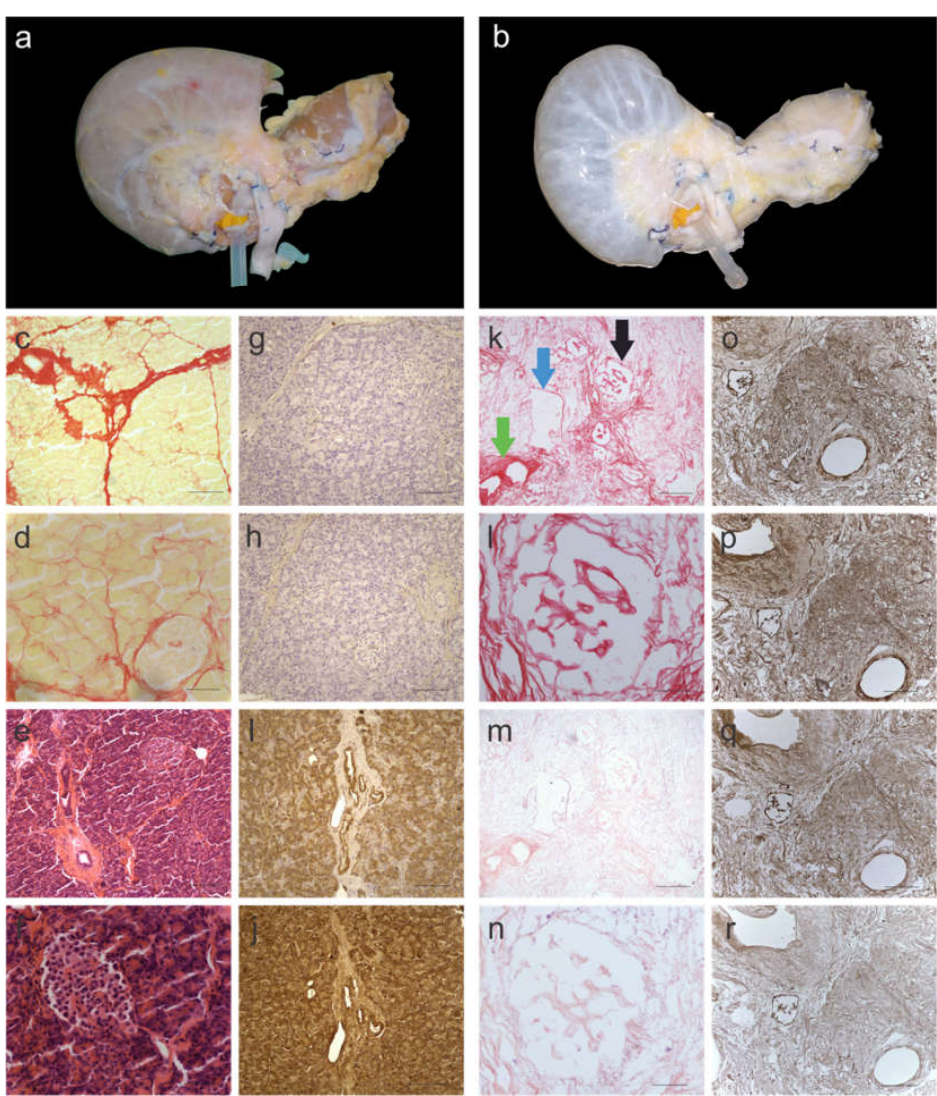
Figure 1. Characterization of decellularized human pancreas tissue. ( a ) before and ( b ) after decellu- larization. Yellow/pink tissue is a representative of cellular material, which is the colour of fresh pancreata, whereas the translucent-white color is a representative of decellularized tissue. Histolog- ical images of native pancreas stained with Picro-Sirius Red (SR) and imaged at ( c ) 10× and ( d ) 40× magnification. SR stains cellular material yellow and collagen fibres red. Histological images of na- tive pancreas stained with H&E and imaged at ( e ) 10× and ( f ) 40× magnification. H&E stains nuclear material blue and the ECM red. Immunohistology images of native pancreas stained for ( g ) collagen I, ( h ) collagen III, ( i ) fibronectin and ( j ) laminin. Histological images of decellularized pancreas stained with SR and imaged at ( k ) 10× and ( l ) 40× magnification. SR staining showed no evidence of cellular material. Histological images of decellularized pancreas stained with H&E and imaged at ( m ) 10× and ( n ) 40× magnification. H&E staining showed no evidence of nuclear material. Immuno- histology images of decellularized pancreas stained for ( o ) collagen I, ( p ) collagen III, ( q ) fibronectin and ( r ) laminin. The black arrow is pointing at an islet of Langerhans, the green arrow is pointing at an exocrine ECM duct and the blue arrow is pointing at a blood vessel, which were well maintained in decellularized pancreata. Scale bars for ( c , k , e , m ) are 200 μm, for ( d , f , l , n ) are 50 μm and for ( g – j and o – r ) are 100 μm. ( n = 6 pancreata).